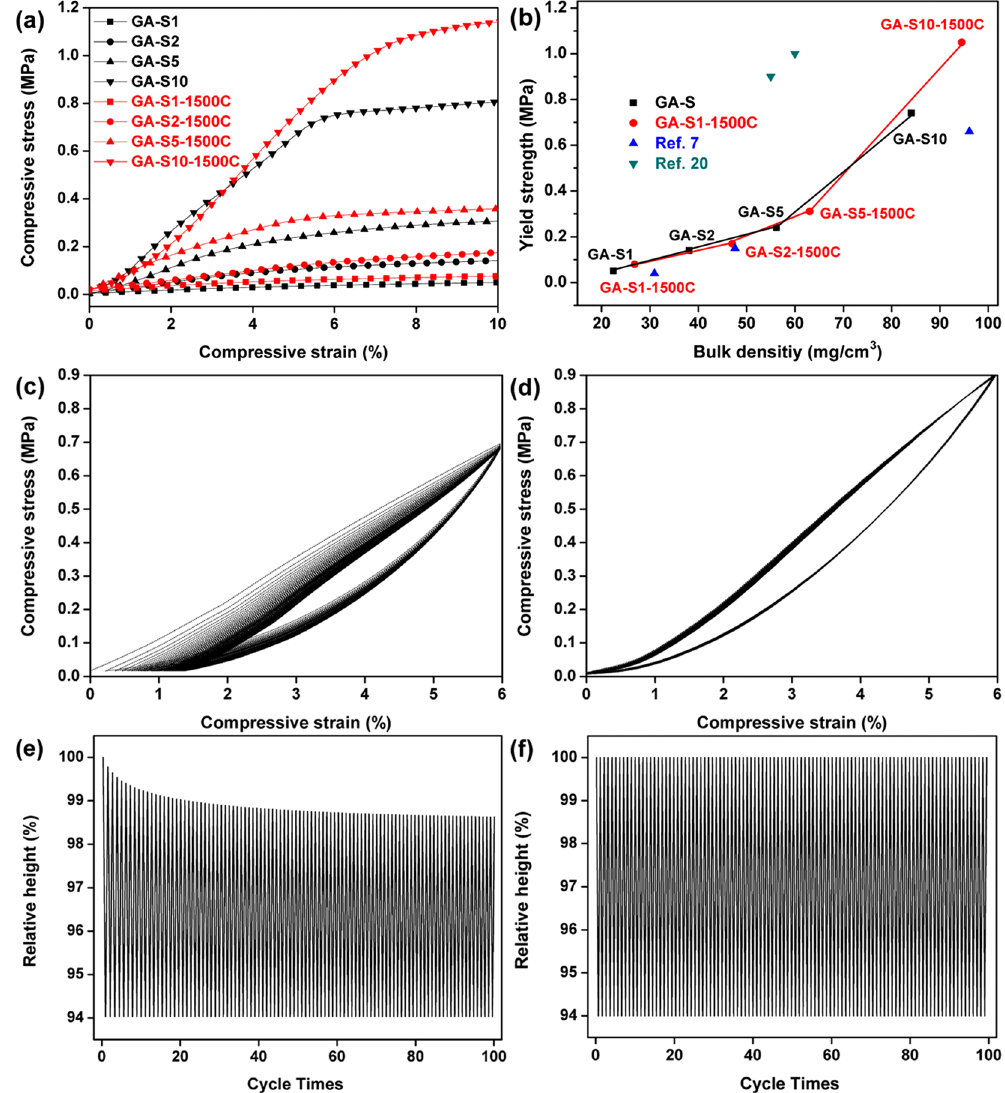
mechanically strong graphene aerogels. Stress–strain curves of ( c ) GA-S10 and ( d ) GA-S10-1500C upon repeated compression to 6% strain for 100 cycles. Relative heights of graphene aerogel cylinders in cyclic compression process for ( e ) GA-S10 and ( f )